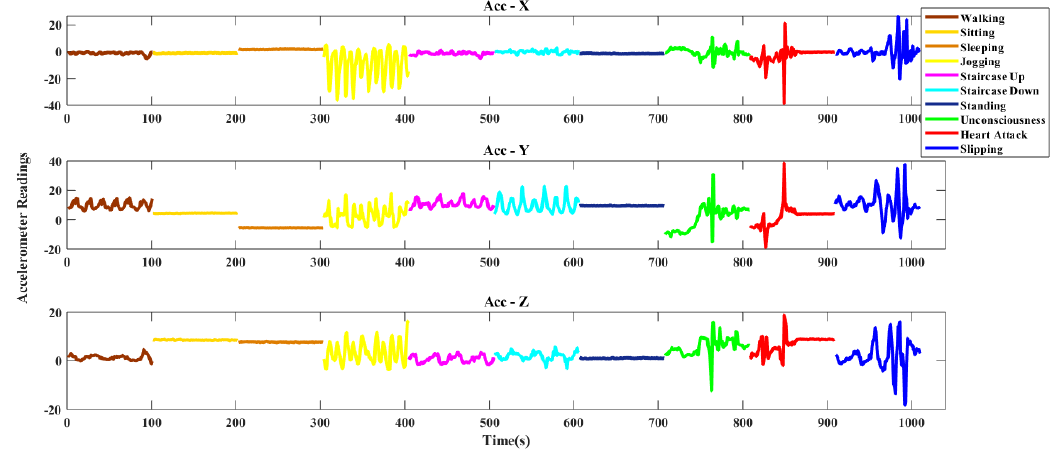
Figure 7. Triaxial accelerometer data of DU-MD